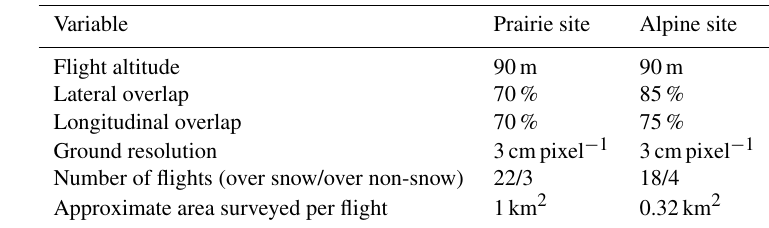
Figure 1. Orthomosaics of (a) the prairie site located near Rosthern, Saskatchewan, and (b) the alpine site at Fortress Mountain Snow Laboratory, Kananaskis, Alberta. The prairie site image (19 March 2015) has polygons depicting areas used for peak snow depth estimation over short (yellow) and tall (green) stubble. The alpine site image (22 May 2015) was split into two separately processed subareas (red polygons). Red points in (a) and (b) are locations of manual snow depth measurements while green points at the alpine site (b) were used to test the accuracy of the DSM over the bare surface. Ground control point (GCP) locations are identified as blue points. Axes are UTM coordinates for the prairie site (UTM zone 13N) and alpine site (UTM zone 11N). The defining features were (c) the wheat stubble (tall) exposed above the snow surface at the prairie site and (d) the complex terrain as depicted by the generated point cloud at the alpine site (view from NE to SW). Table 1. Flight plan